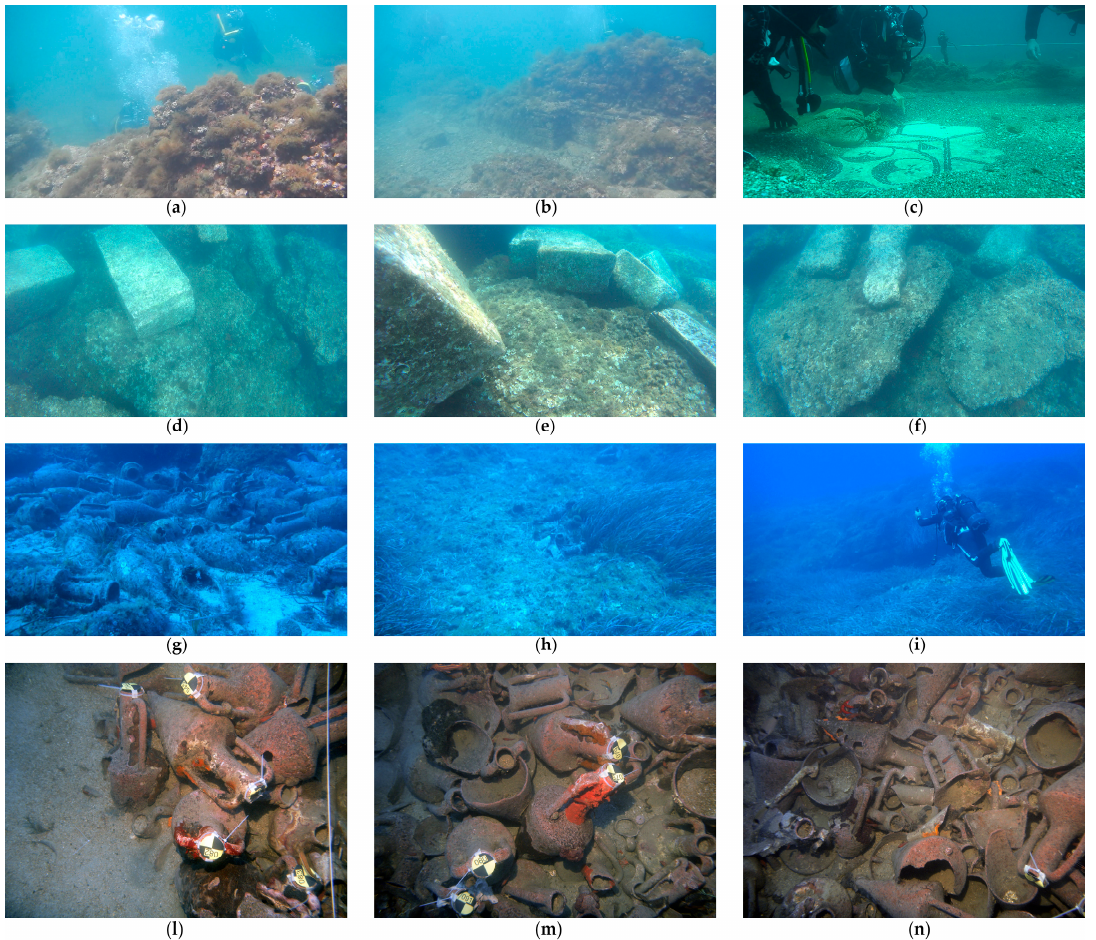
Figure 1. Underwater images dataset. ( a – c ) Images acquired at Underwater Archaeological Park of Baiae, named respectively Baia1, Baia2, Baia3. Credits: MiBACT-ISCR; ( d – f ) Images acquired at Cala Cicala shipwreck, named respectively CalaCicala1, CalaCicala2, CalaCicala3. Credits: University of Calabria; ( g – i ) Images acquired at Cala Minnola, named respectively CalaMinnola1, CalaMinnola2, CalaMinnola3. Credits: University of Calabria; ( l – n ) Images acquired at Mazotos, named respectively Mazotos1, Mazotos2, Mazotos3. Credits: MARELab, University of Cyprus.